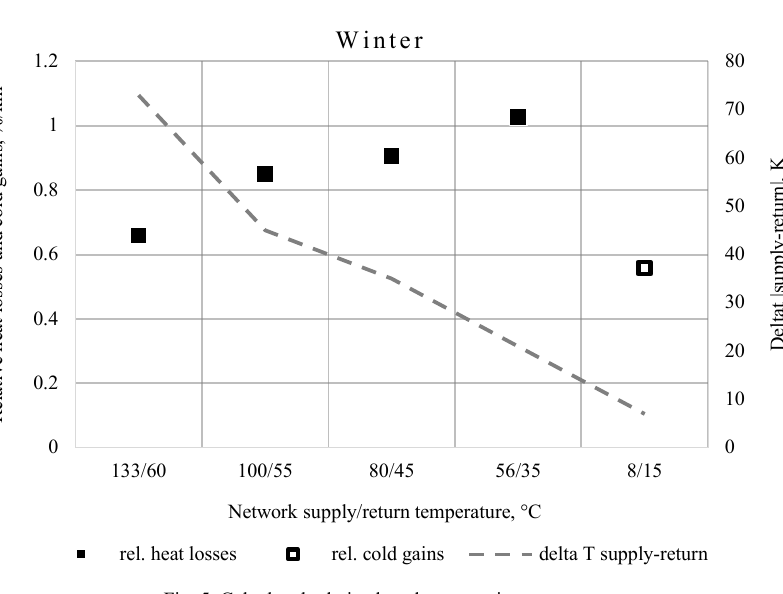
Fig. 5. Calculated relative heat losses – winter